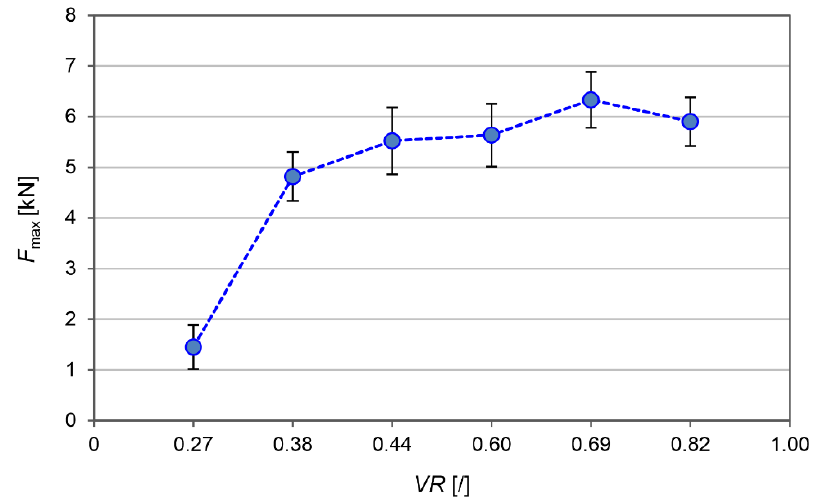
Figure 7. The influence of volume ratio on the rivet pull-out strength. The third type of failure with the breakage of the AA2024-T351 rivet was observed in specimens #3, #4, #6 and #7. In this failure mode, the highest pull-out forces were required to separate the rivet joint, and the highest ultimate pull-out force was observed when the final end shape of the rivet formed an anchor shape, with a volumetric ratio of 0.69 for both of these experiments, i.e., processing parameters #6 and #7.